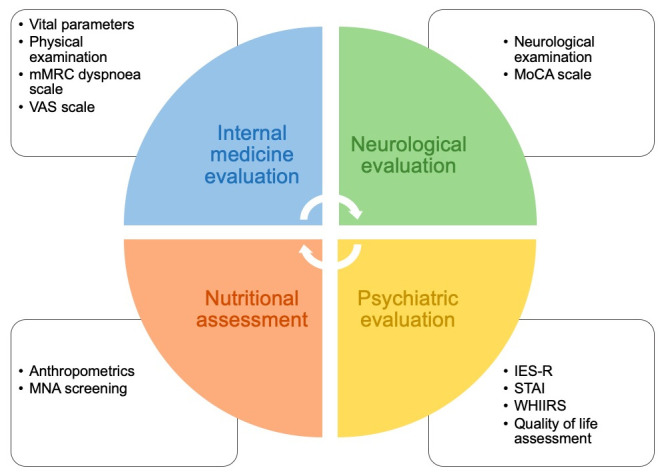
Multidisciplinary organisation and assessment measures of the COVID-19 Follow-up Outpatient Clinic at San Raffaele University Hospital.mMRC, modified Medical Research Council. VAS, visuo-analog scale. MoCA, Montreal Cognitive Assessment. MNA, Mini Nutritional Assessment. IES-R, Impact of Event Scale-Revised. STAI-Y, State-Trait Anxiety Inventory form Y. WHIIRS, Women’s Health Initiative Insomnia Rating Scale.